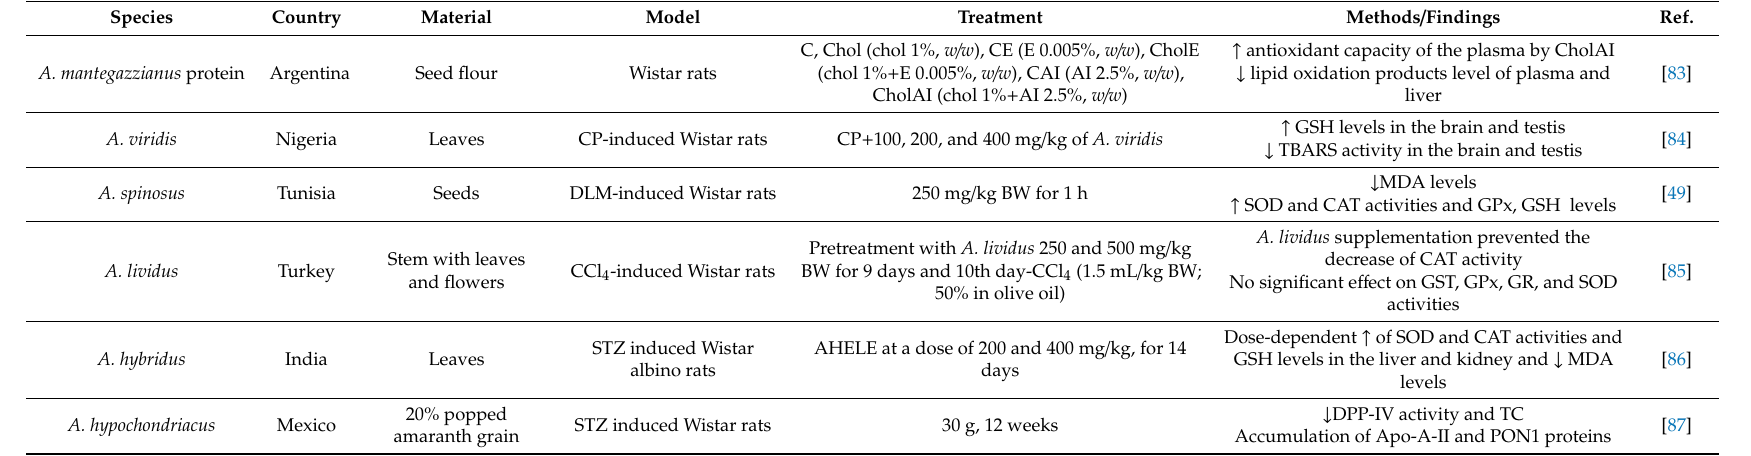
Table 3. In vivo studies showing the antioxidant capacity of Amaranthus